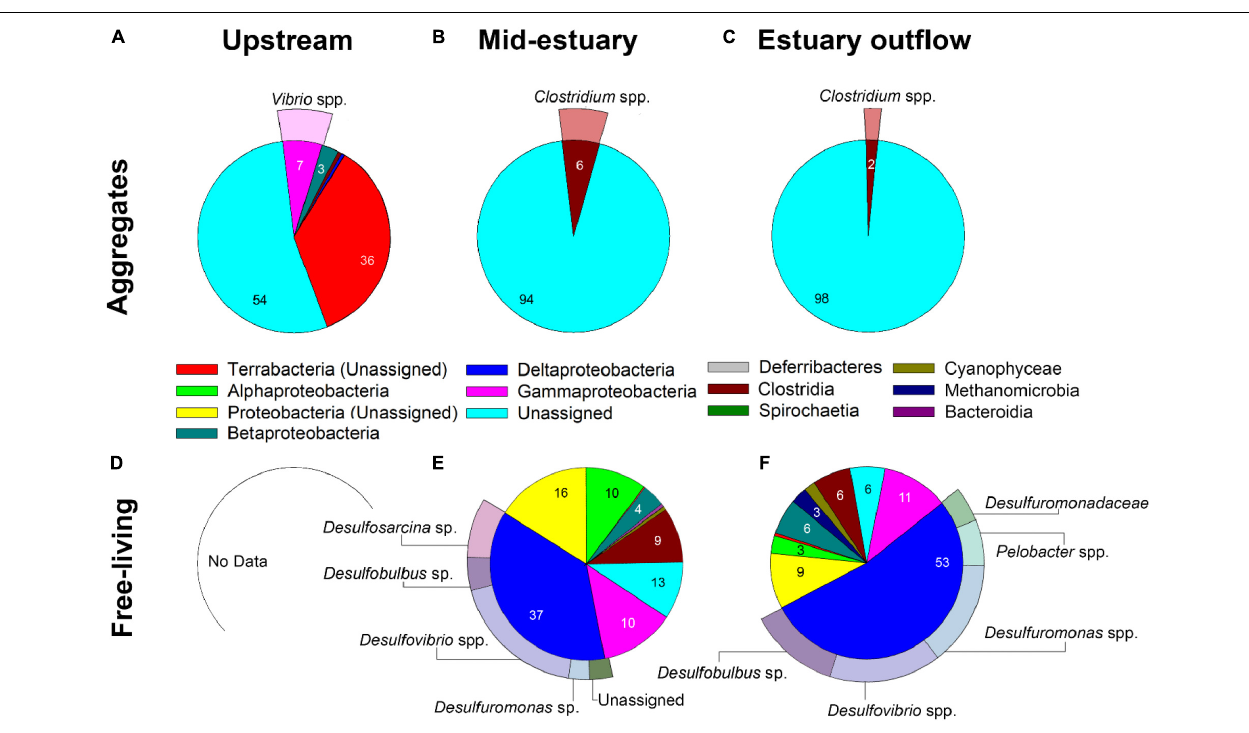
FIGURE 5 | Summertime diazotrophic community composition at the Qishon River derived from nifH analyses associated with aggregates (A–C) and as free-living bacteria (D–F) . Numbers represent relative abundance (%, mean = 3,700 OTUs) of the (class level) OTUs in the sample. Peripheral-pie slices represent the genus of the most abundant (and assigned) class in a sample. The remaining classes are shown in Supplementary Table 2 . Data for free-living diazotrophs upstream is not available due to technical